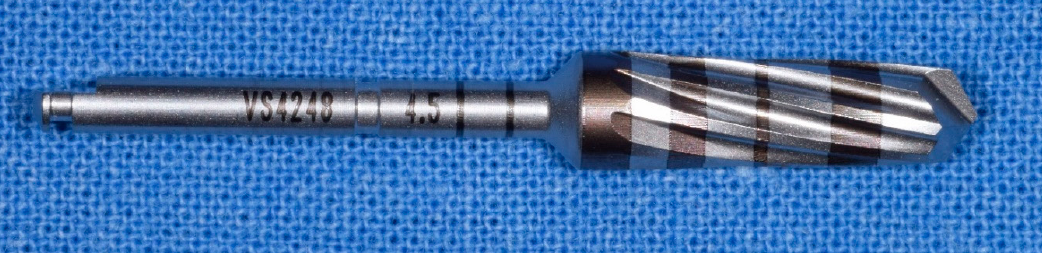
Figure 10. Tenth cutter with a diameter of 4.5 mm in the method “implant drilling with bone compaction instrumentation technique.”